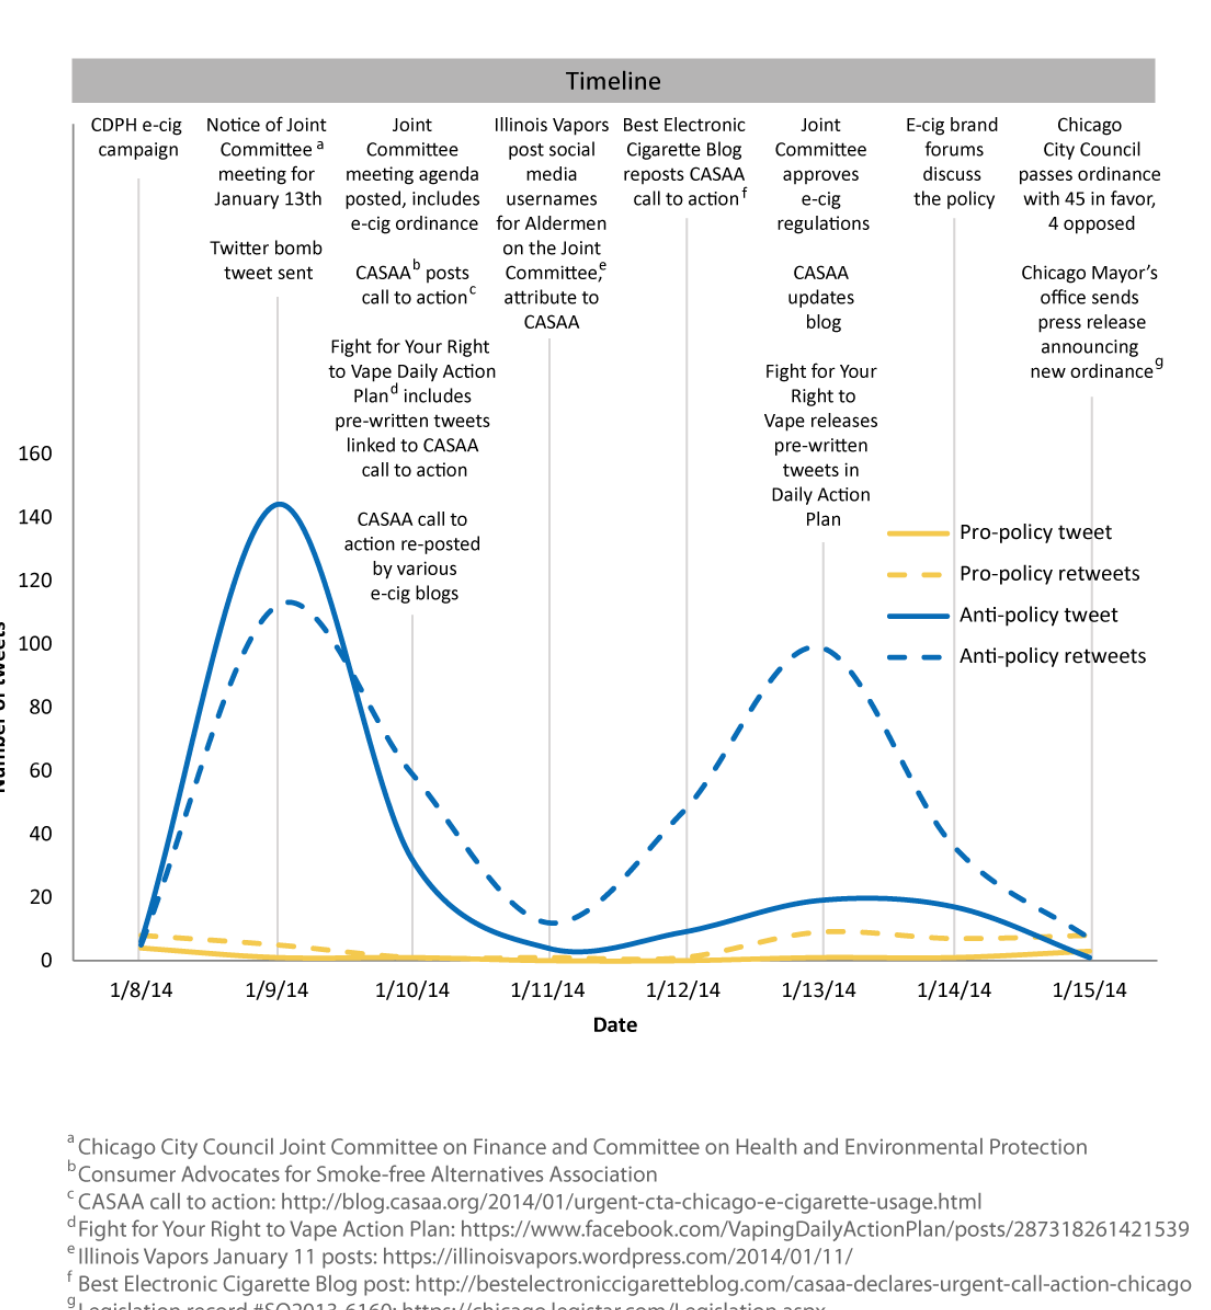
Figure 1. Timeline showing social media activities and distribution of tweets and retweets directed to @ChiPublicHealth in support of and opposing regulation of e-cigarettes in